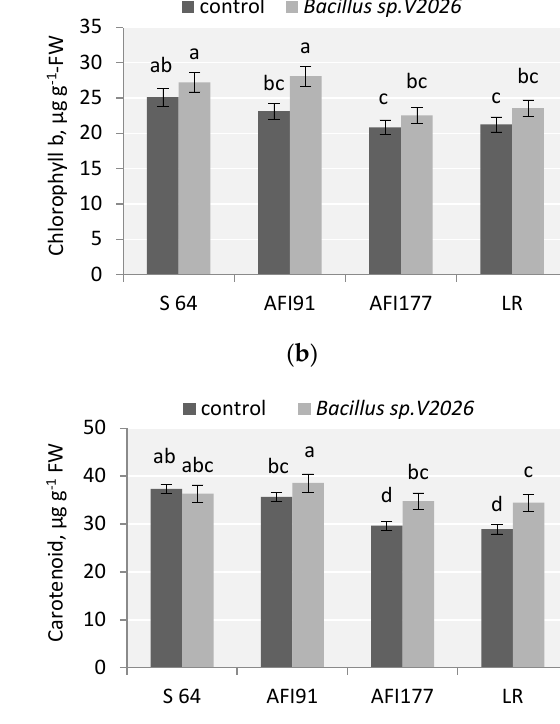
Changes in tZ content were most noticeable in cv. LR; its level increased two-fold in shoots and five-fold in roots (Figure 5e,f).